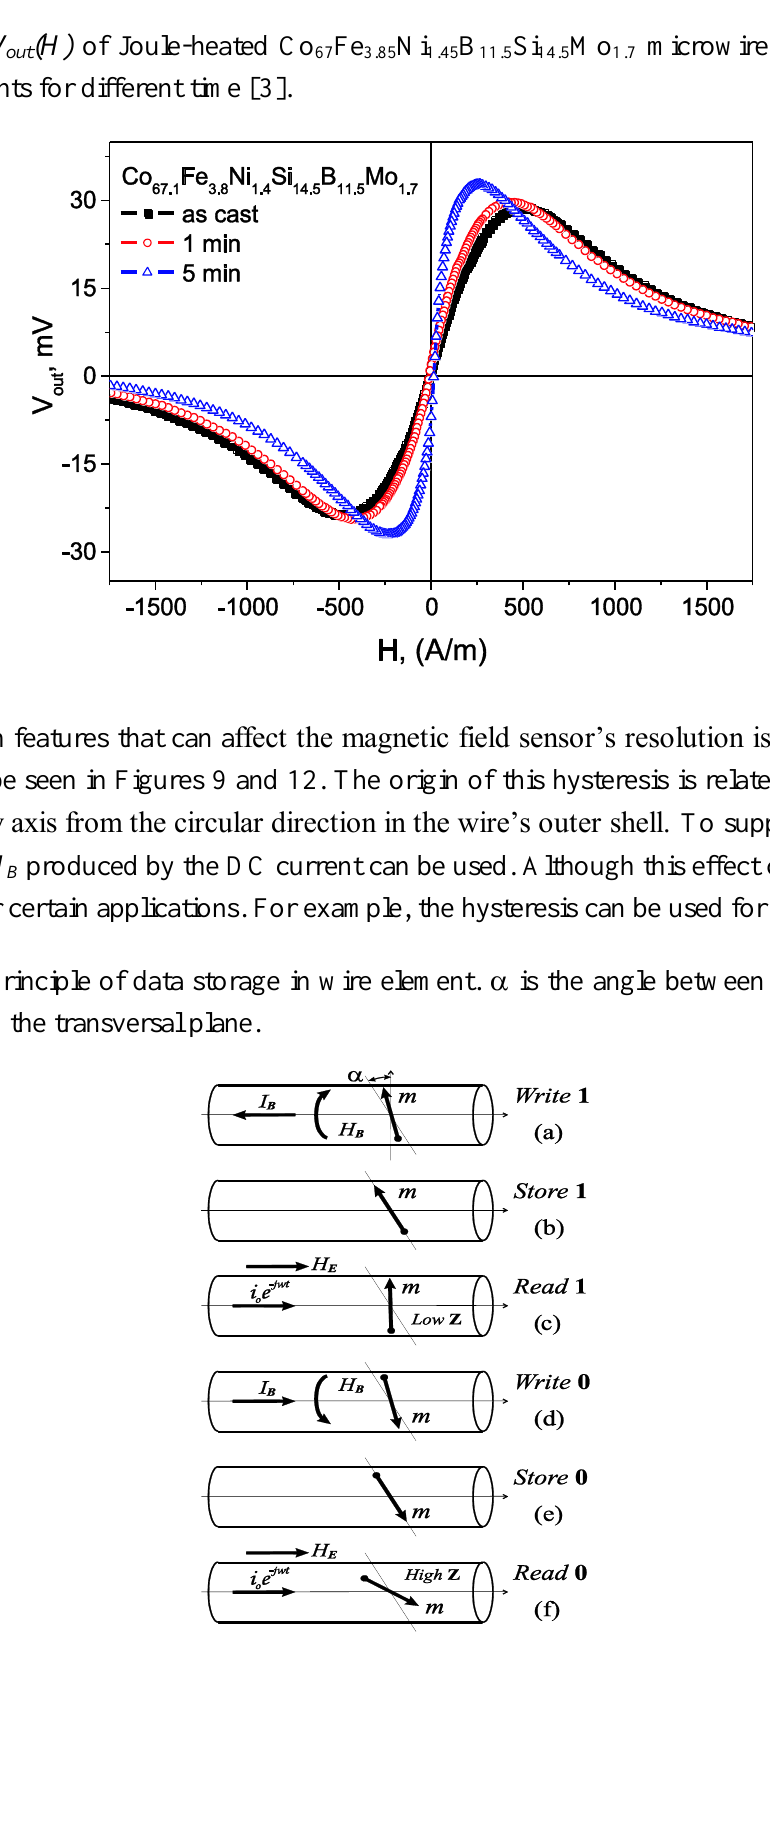
(H) of Joule-heated Co out